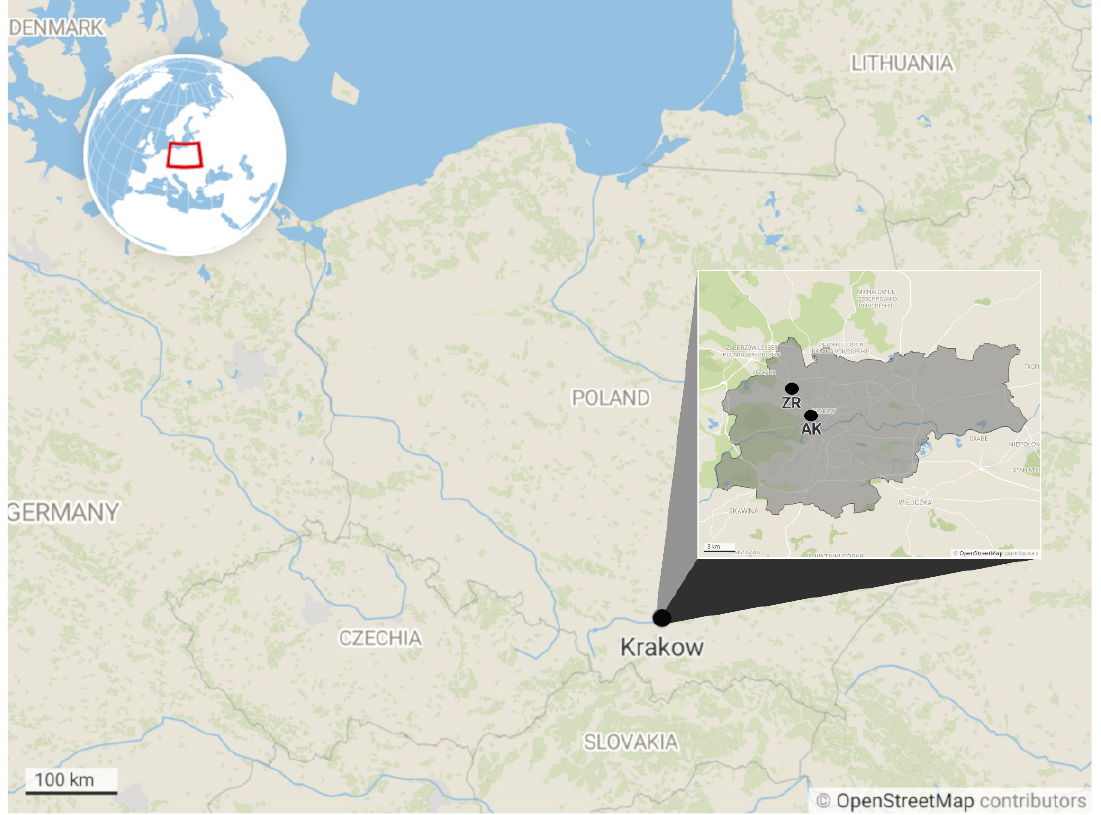
Figure 2. The location of PM10 sampling sites in Krakow. AK—traffic-dominated site, ZR—urban-background site (Maps OpenStreetMap) [8].